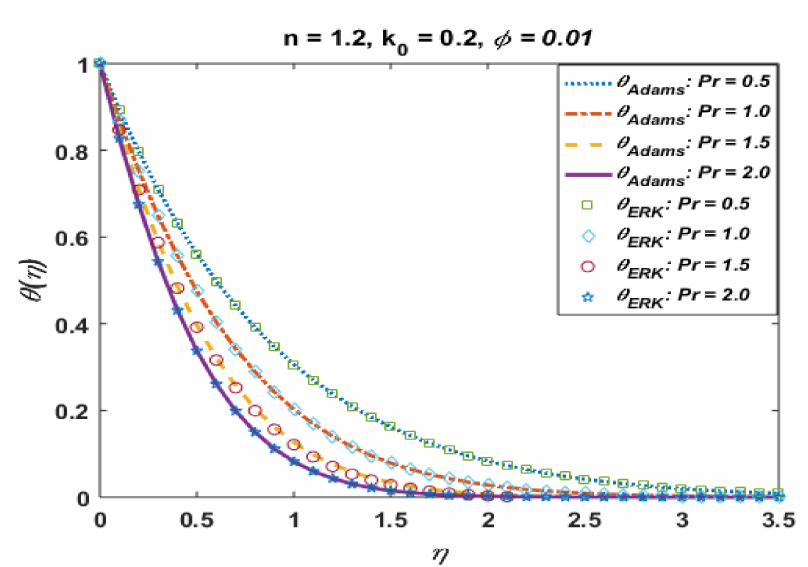
Figure 21. Effects of Pr on θ ( η )